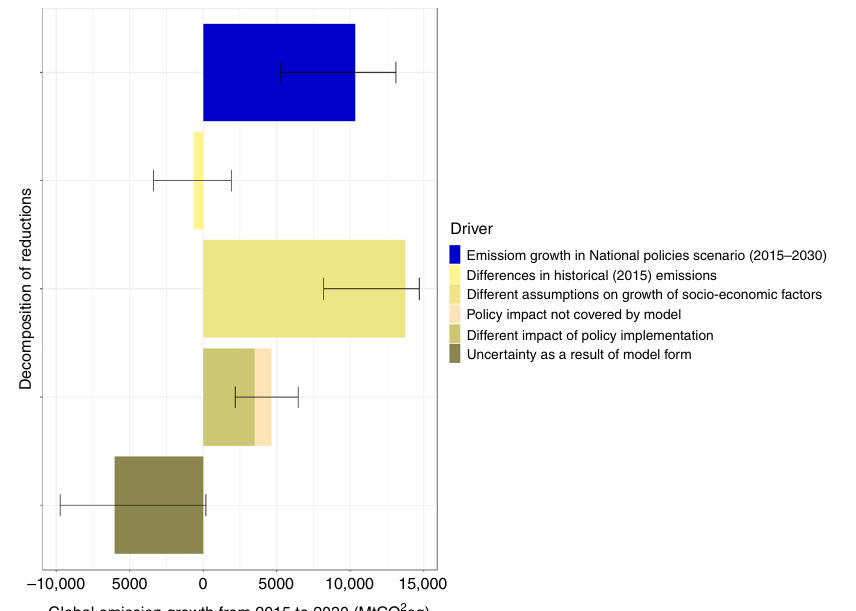
Fig. 5 Decomposition of total median emission growth between 2015 and 2030 under National policies scenario, error bars range between 10th to and 90th percentiles. The data is available in the source